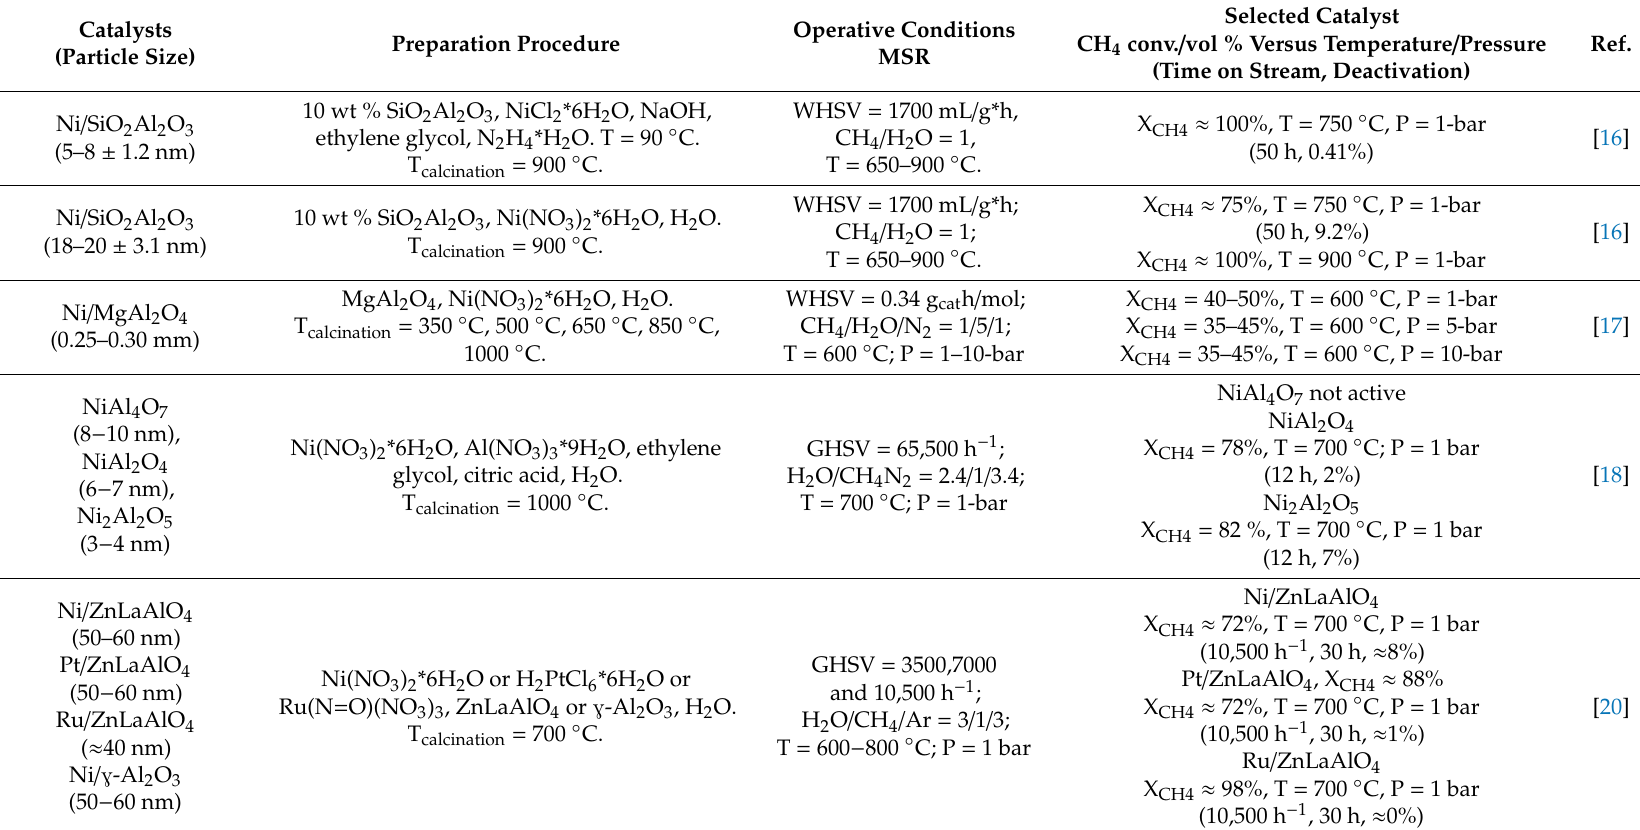
Table 1. Summary of preparation procedures and operative conditions used in monometallic catalysts and related